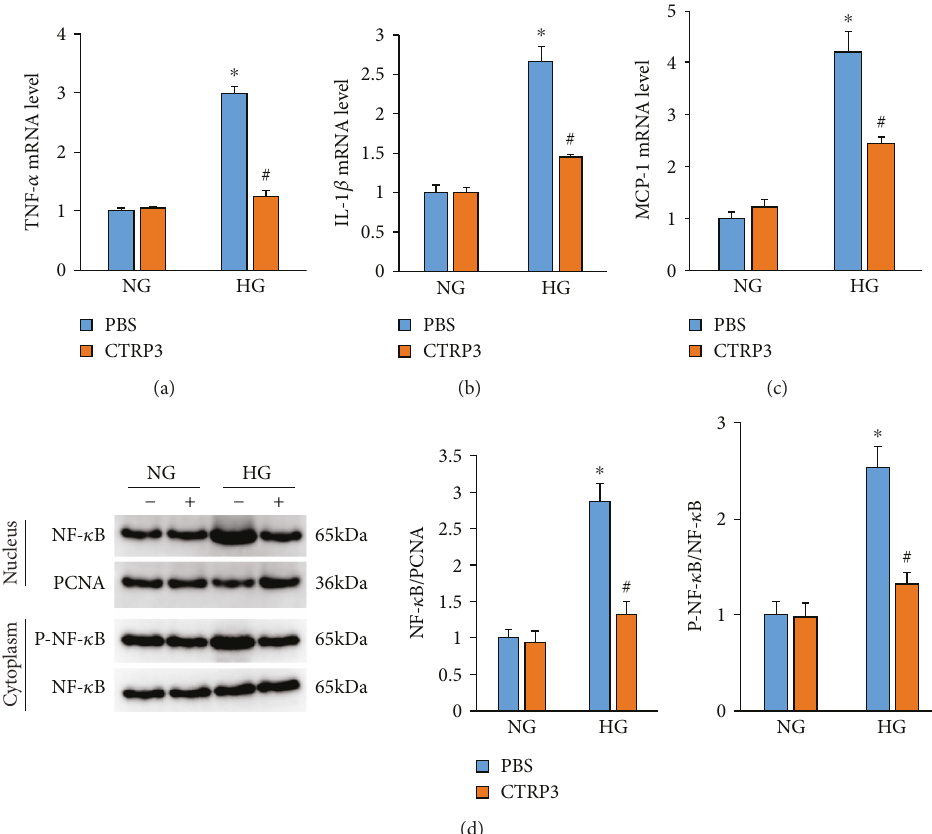
Figure 2: CTRP3 inhibits cell in fl ammation level in HUVECs induced by high glucose. (a – c) The mRNA expression of in fl ammatory factors in HUVECs exposed to high glucose ( n = 5 ). (d) The protein expression of NF- κ B was detected by western blot analysis ( n = 5 ). Data are expressed as mean ± SD of fi ve independent experiments. ∗ P < 0 05 when compared to the NG group; # P < 0 05 when compared to the HG